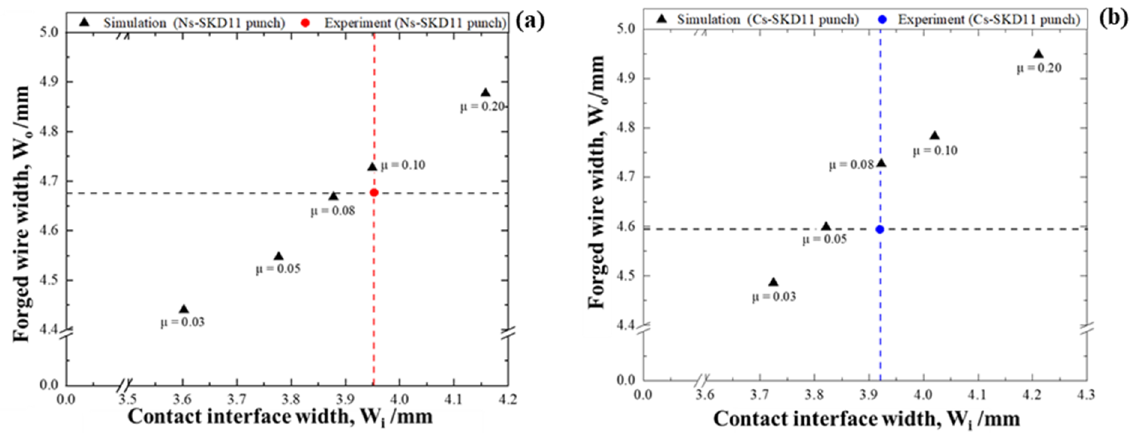
Figure 7. Determination of the friction coefficient ( µ 0 ) on the contact interface between the punch and the pure titanium wire with the aid of the finite element analysis. ( a ) Estimate of μ 0 on the contact interface between Ns-SKD11 punch and pure titanium wire, and ( b ) estimate of μ 0 on the contact interface between Cs-SKD11 punch and pure titanium wire.